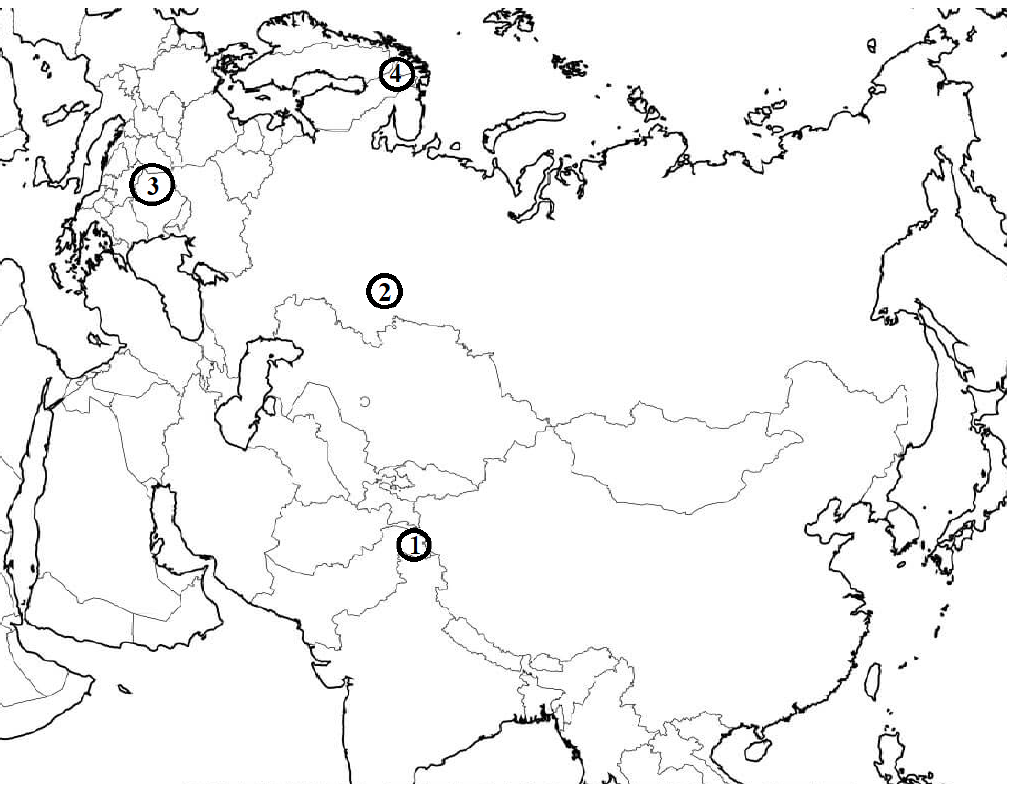
Figure 1. The three places of my case studies: (1) Hunza, (2) the Middle Ural, (3) Transylvania, and (4) Sápmi. 10 .